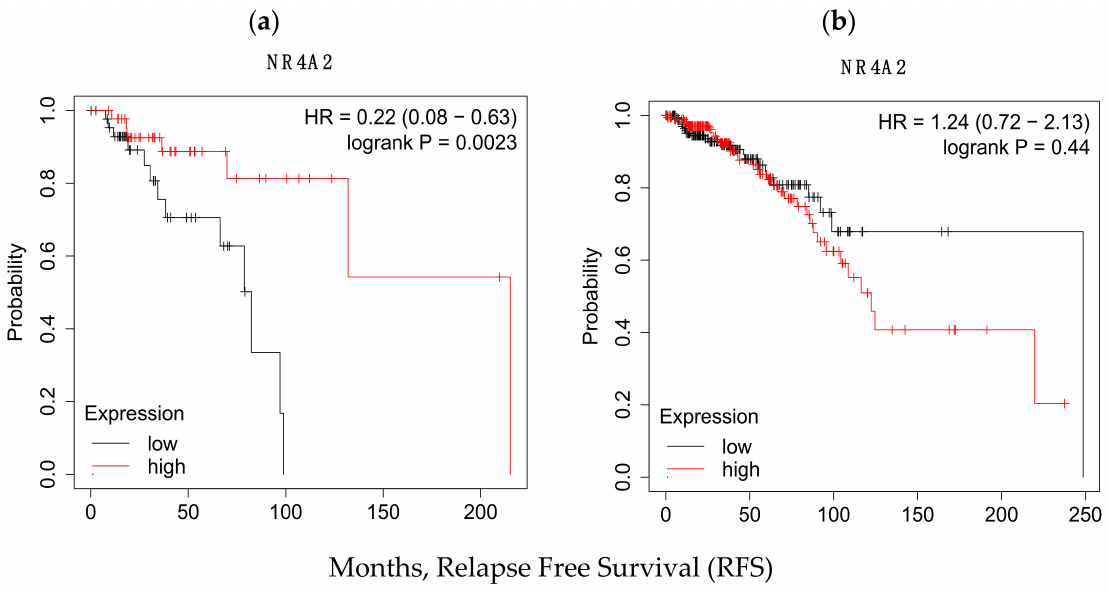
Figure 3. KM plots indicating the significant variation in the RFS values in ( a ) Black and ( b ) White racial groups as function of NURR1 expression in upper and lower quartile. In Black population low expression of NURR1 expression is associated with poor RFS (82.3 months) rate while in white it resulted in relatively higher RFS (248.5